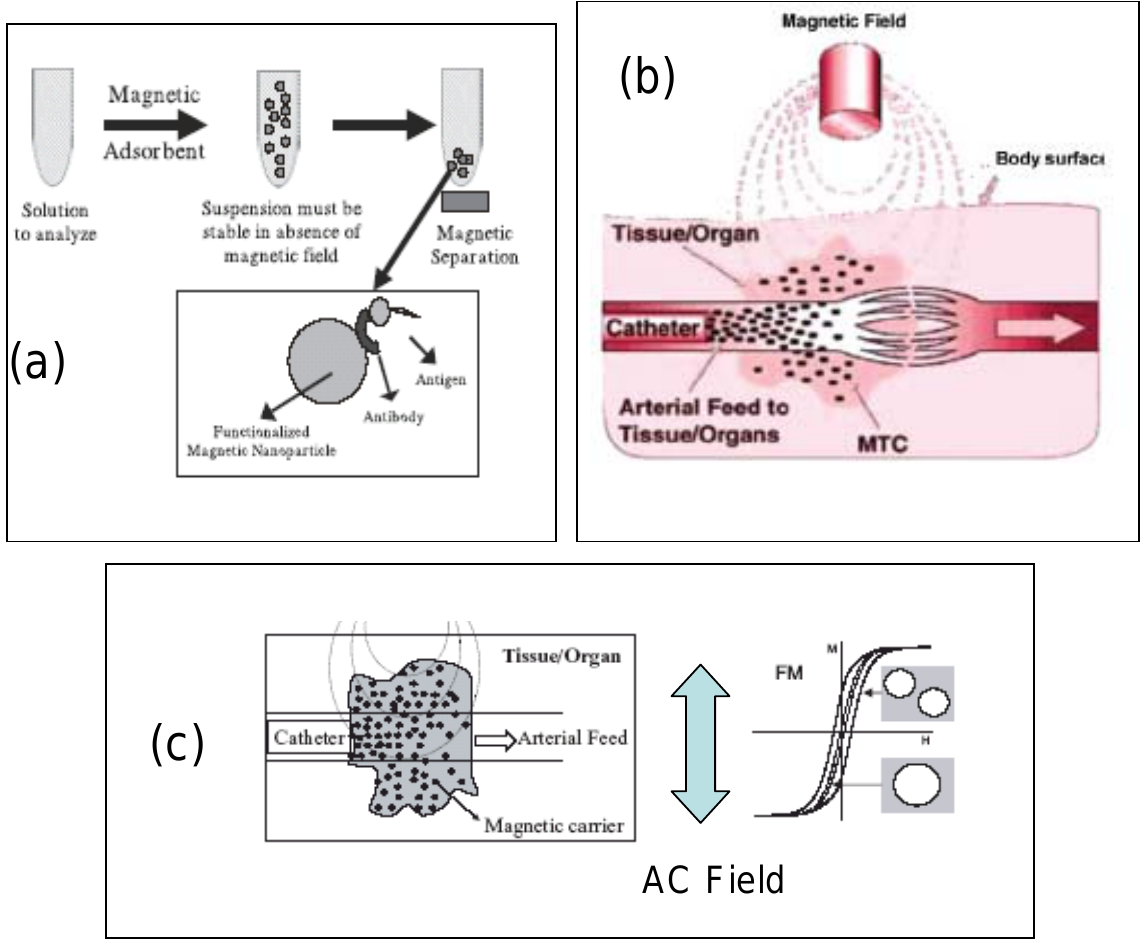
FIGURE 20. Scheme of the (a) cell separation, (b) drug delivery, and (c) hyperthermia using magnetic NP. (From refs. [5,132,134]). Reproduced with permission of the